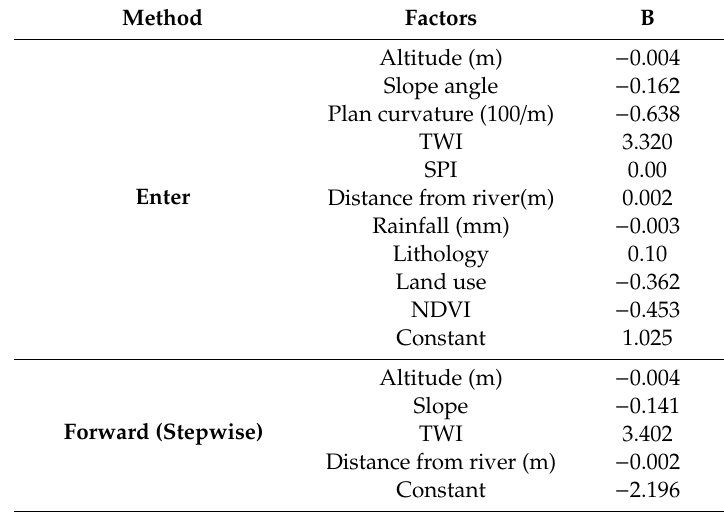
Table 5. Conditioning factor coe ffi cients for the enter and stepwise LR methods.